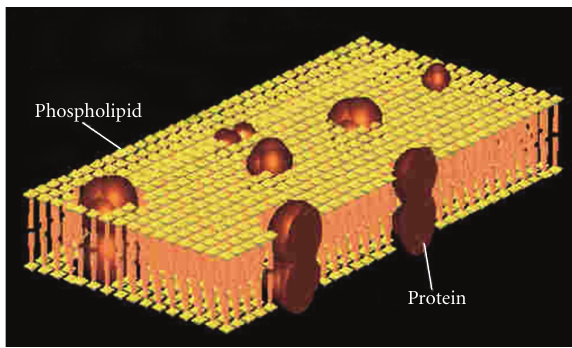
Figure 1: Cellular membrane structure